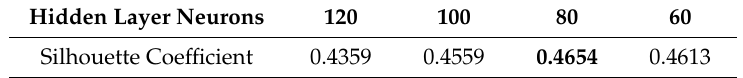
Figure 8. RBM model training error rate with iterations. Table 1. Silhouette Coe ffi cient performance of clustering based on various hidden layer neurons.